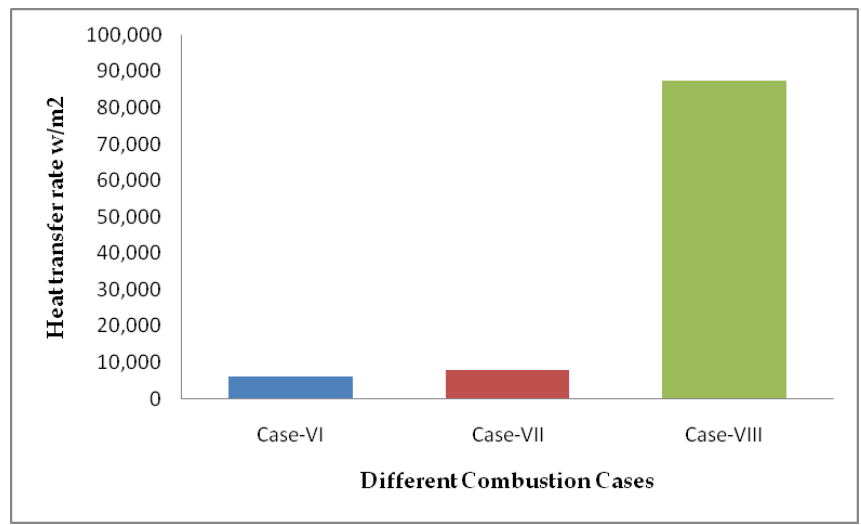
Figure 19. Heat transfer of tube from furnace flame to tubes for three cases.